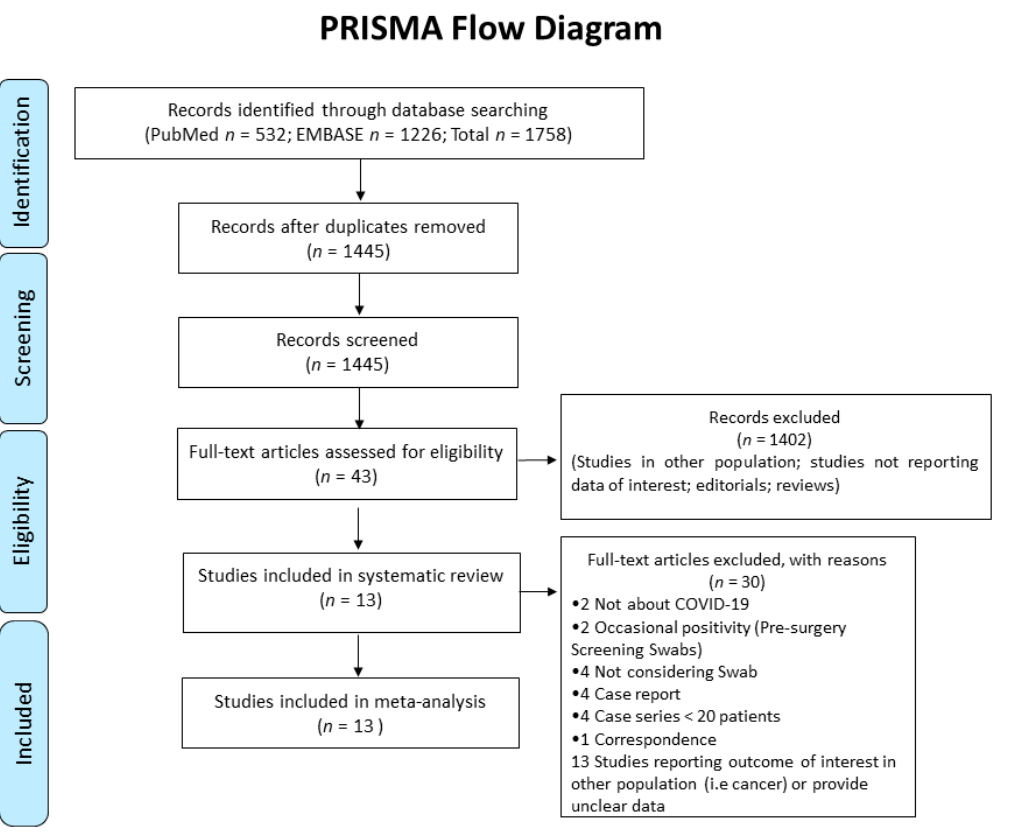
Figure 1. Flow-chart of study